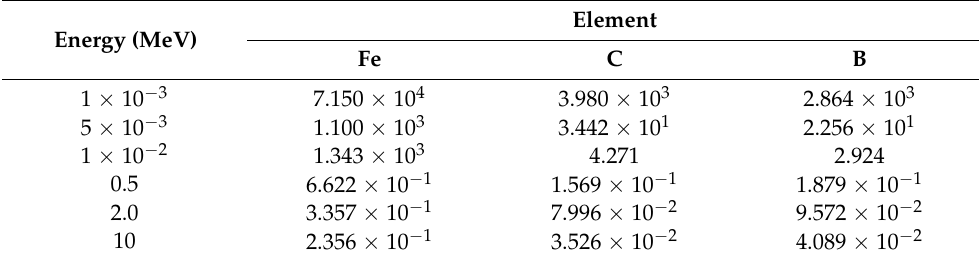
Table 1. γ ray linear attenuation coefficients (cm − 1 ) of the main element.